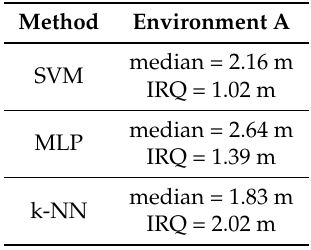
Table 4. Error median and IQR for the three fingerprinting based algorithms in Environment A after adding a large object not present during the collection of the